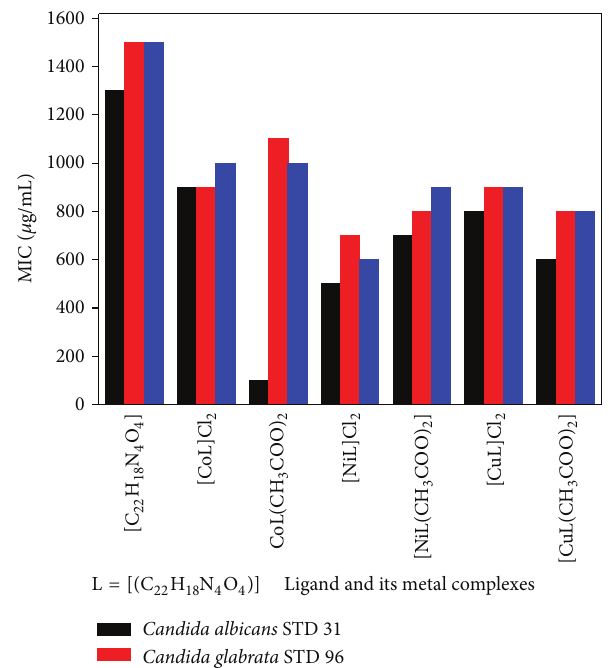
Figure 1: Minimum inhibitory concentration (90%) of the syn- thesized ligand and its metal complexes against different clinical fluconazole-sensitive Candida